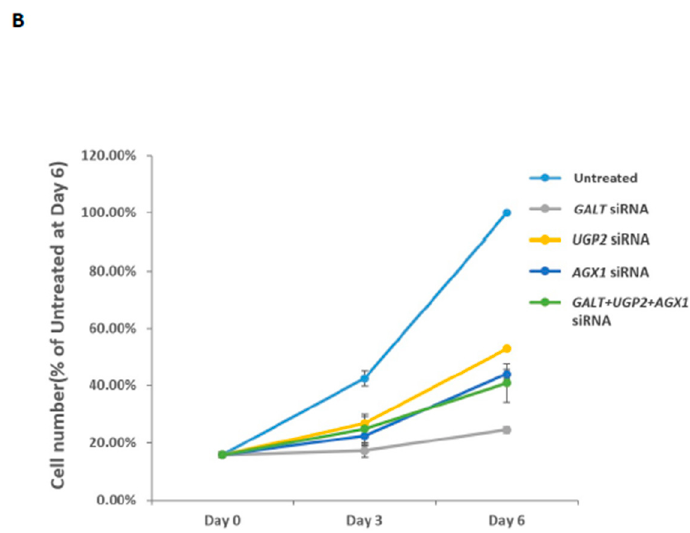
Figure 4. Validation of UDP-hexose pyrophorylases as anti-cancer targets by siRNA experiments. ( A ) Relative mRNA levels of GALT , UGP2 and AGX1 / UAP1 in PC3 cells 72 h after respective siRNA transfections. Results were normalized to those found in untreated cells (100%). ( B ) Inhibition of PC3 cell growth by siRNA against GALT , UGP2 and AGX1 / UAP1 genes.